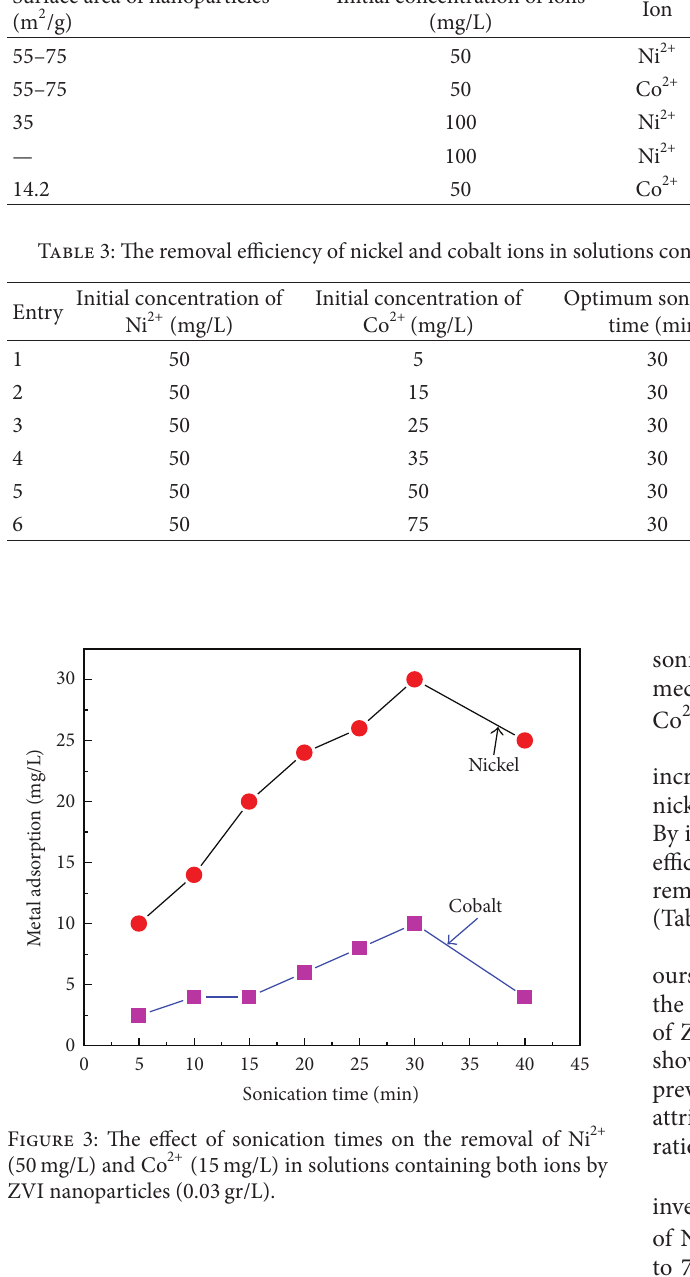
T 2: Comparative applicability of ZVI nanoparticles for removal of nickel and cobalt ions. Surface area of nanoparticles